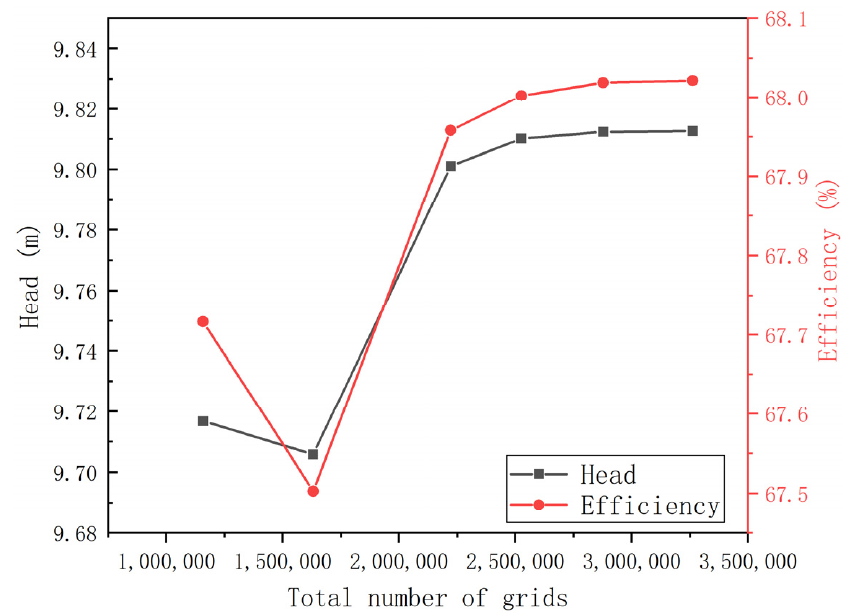
Figure 6. Analysis of Independence of Impeller Grid.